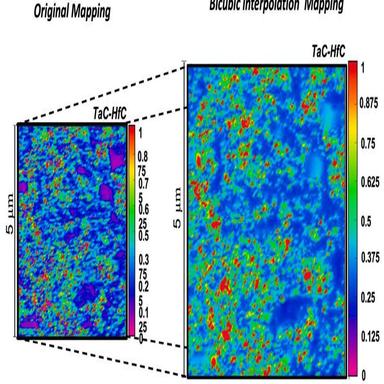
Graphical representation of rectified modulus mapping with the modified bicubic interpolator for TaC-HfC sample.